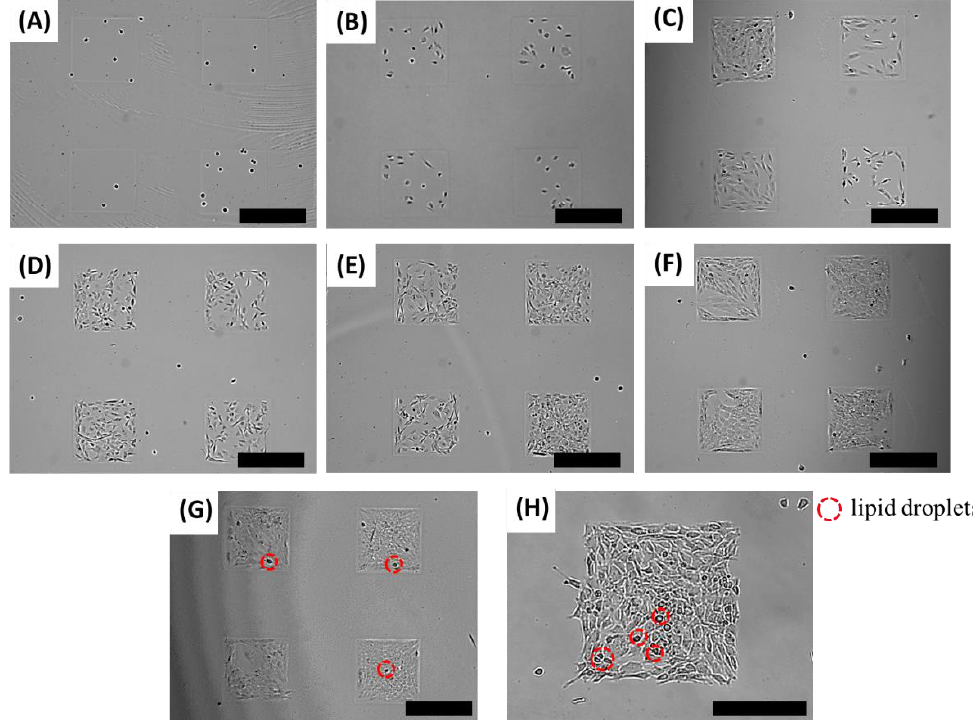
Figure 3. Optical images of the adipocyte micro-cell pattern chip after being cultured for ( A ) 0.5 h, ( B ) 12 h, ( C ) 1 day, ( D ) 2 days, ( E ) 3 days, ( F ) 4 days, ( G ) 6 days and ( H ) 8 days with 3T3-L1 cells on an adipocyte micro-cell pattern chip. Scale bar indicates ( A – G ) 500 μ m and ( H ) 300 μ m.